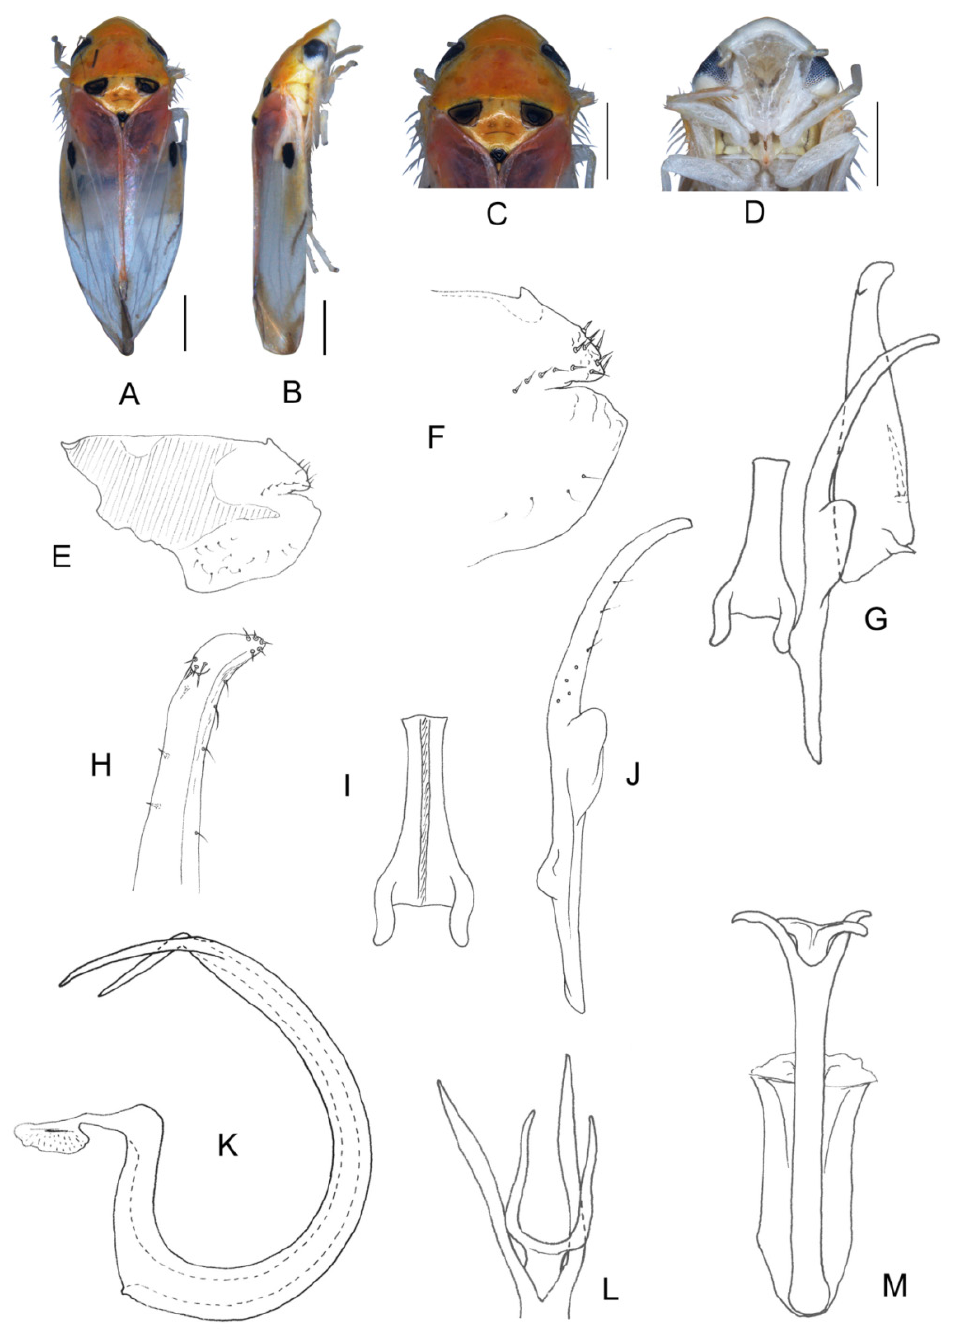
Figure 21. Eurhadina ( Singhardina ) uprotrusa sp. nov. : ( A ) habitus, dorsal view; ( B ) habitus, lateral view; ( C ) head and thorax, dorsal view; ( D ) face; ( E ) male pygofer side, lateral view; ( F ) hind part of pygofer, lateral view; ( G ) subgenital plate, connective and paramere, lateral view; ( H ) apex of subgenital plate, lateral view; ( I ) connective, lateral view; ( J ) paramere, lateral view; ( K ) aedeagus, posterior view; ( L ) apex of aedeagal shaft, dorsal view; and ( M ) aedeagus, lateral view. Scale bars: 0.5 mm. Body yellowish ochre. Face sordid white. Crown, pronotum, and scutellum yellowish ochre; basal triangles blackish, scutellum with a blackish patch on apex. Forewing pale white with pale pinkish patch on basal part of corium and clavus; brochosome area